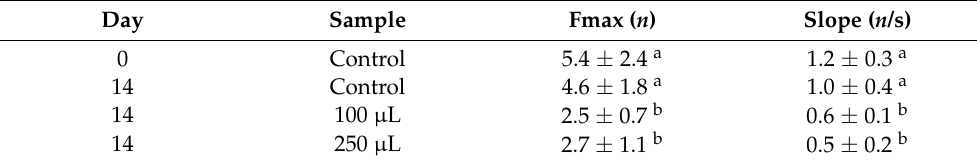
a b : different letters in a colour parameter indicate that there are significant differences between samples or conditions ( α < 0.05).